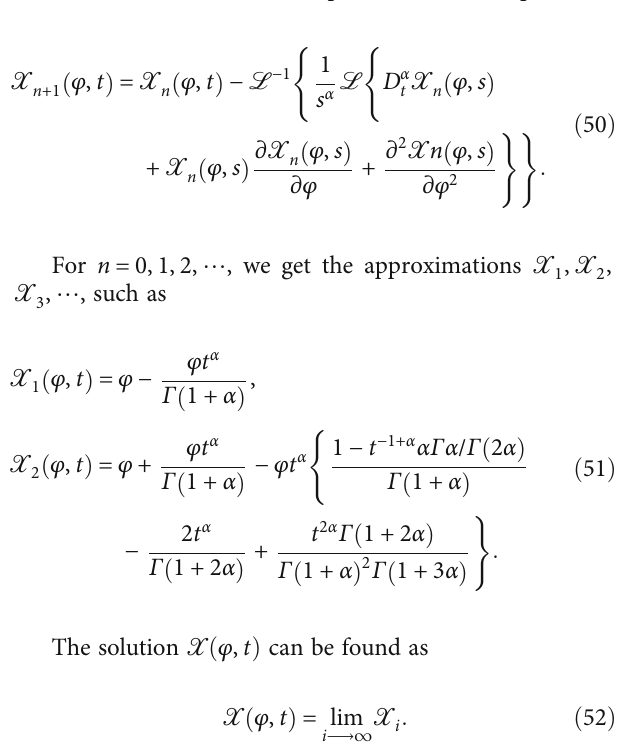
Figure 2: 3D representation of X for α = 0 : 2 (a) and α = 0 : 8